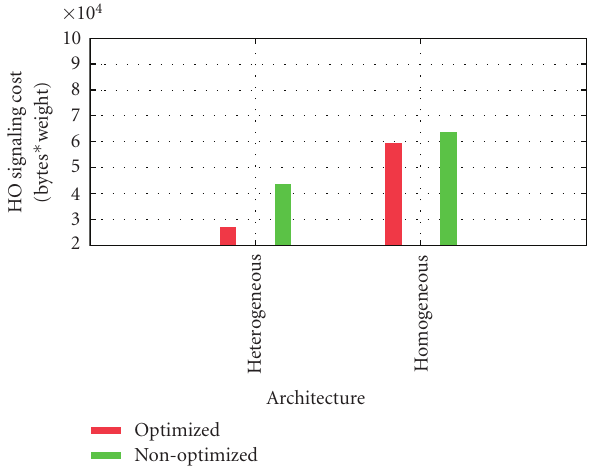
Figure 15: Basic configuration signaling